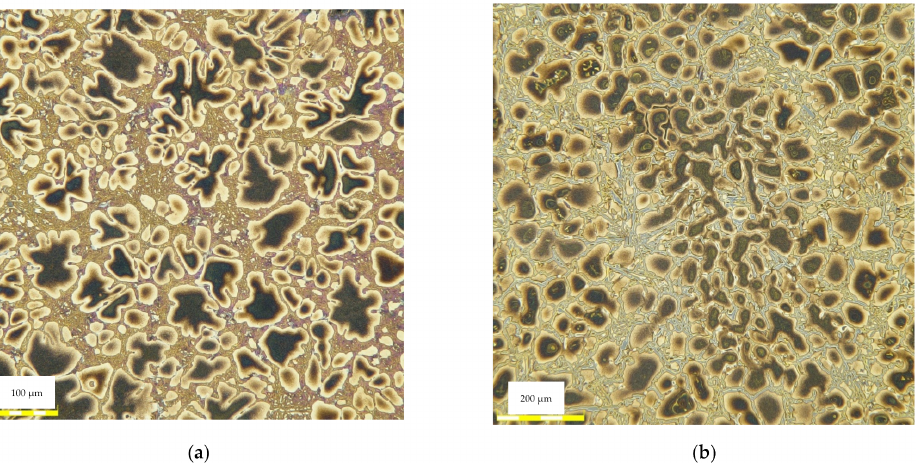
Figure 3. Microstructural illustration from ( a ) 2 kg shot volume and ( b ) 20 kg shot weight, etched using Weck’s reagent. Dark areas were solid in the slurry before quenching. Lighter areas were liquid, contained higher Si contents, and solidified during